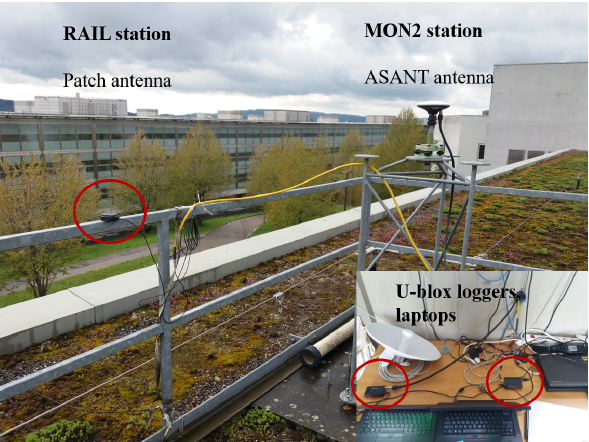
Figure 6. Session 3: experimental setup for station “RAIL” and “MON2” for the static kinematic tests for the u-blox PointPerfect tests, located at the roof of ETH HPV building.